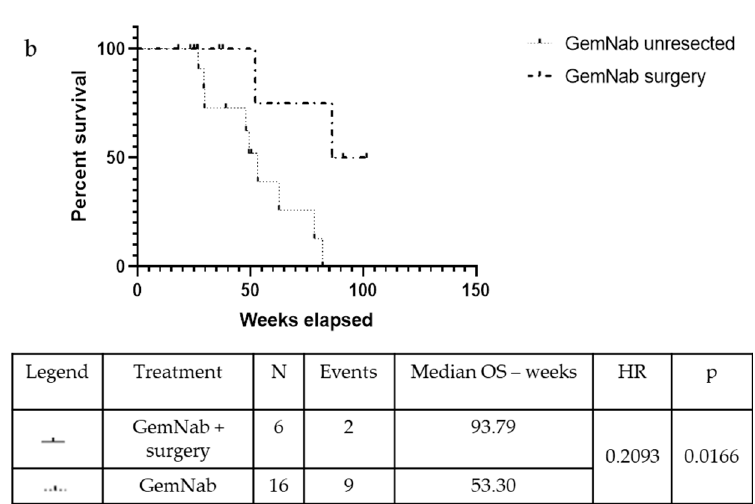
Figure 4. Kaplan-Meyer curve for OS confronting patients who underwent surgery versus unresected patients, after treatment with neoadjuvant FFN (a) or GemNab (b). ( a ) The median Overall Survival (mOS) was not reached in the FFN resected group and 72.10 weeks in the FFN unresected group ( p = 0.0006, 95% C.I. 0.03935–0.4105; HR = 0.13). ( b ) The median Overall Survival (mOS) was 93.79 weeks in the GemNab resected group and 53.30 weeks in the GemNab unresected group ( p = 0.0166, 95% CI 0.05822–0.7523; HR = 0.21).